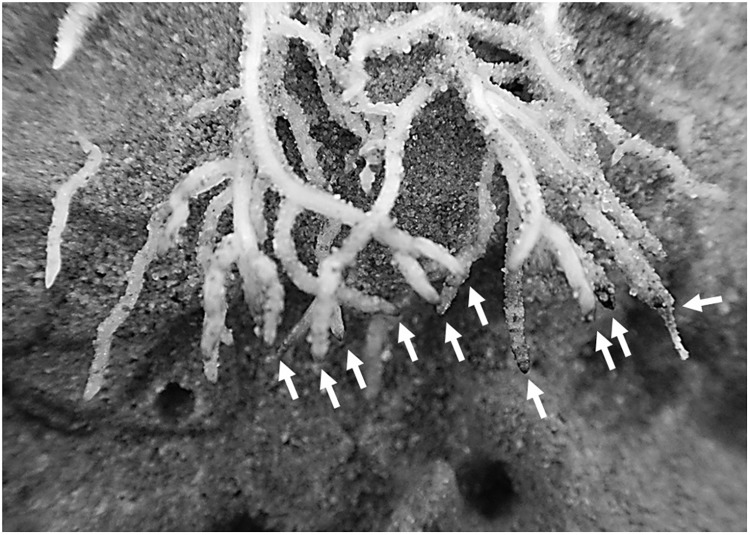
Brown and rotten root tips of S. hermaphrodita grown in digestate depot fertilized rhizotrons occurred in a 6 cm radius around the digestate depot 60 days after planting. Digestate depot fertilization was calculated to simulate a digestate application of 40 t ha−1. Arrows indicate the damaged root tips.